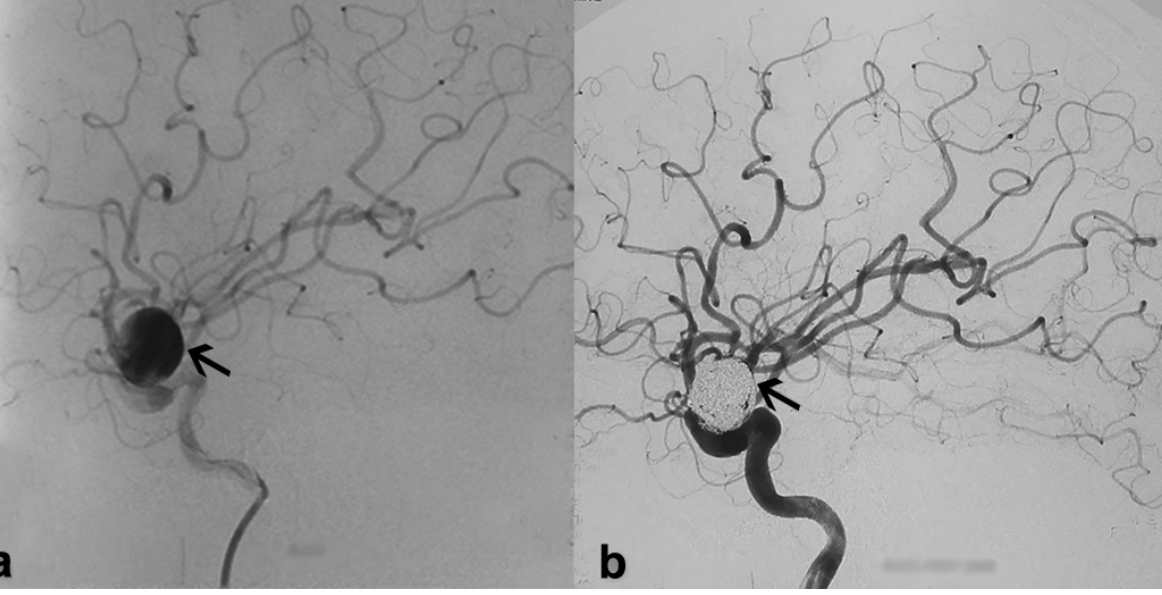
Figure 2: Digital subtraction angiography (DSA) of the aneurysm before and after coiling DSA lateral projection of the aneurysm (left black arrow) pre-treatment (a) and after coiling (right black arrow) (b) shows the right ophthalmic segment internal carotid artery